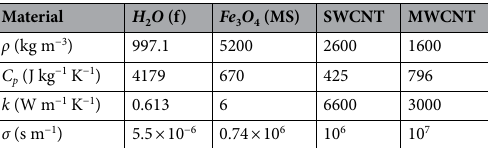
Table 1. Experimental upshots of traits of H 2 O , Fe 3 O 4 , SWCNT and